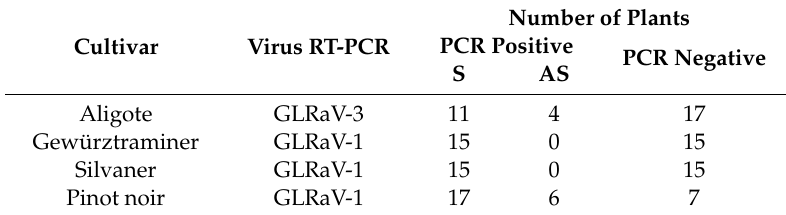
Number of Plants PCR Positive PCR Negative S AS